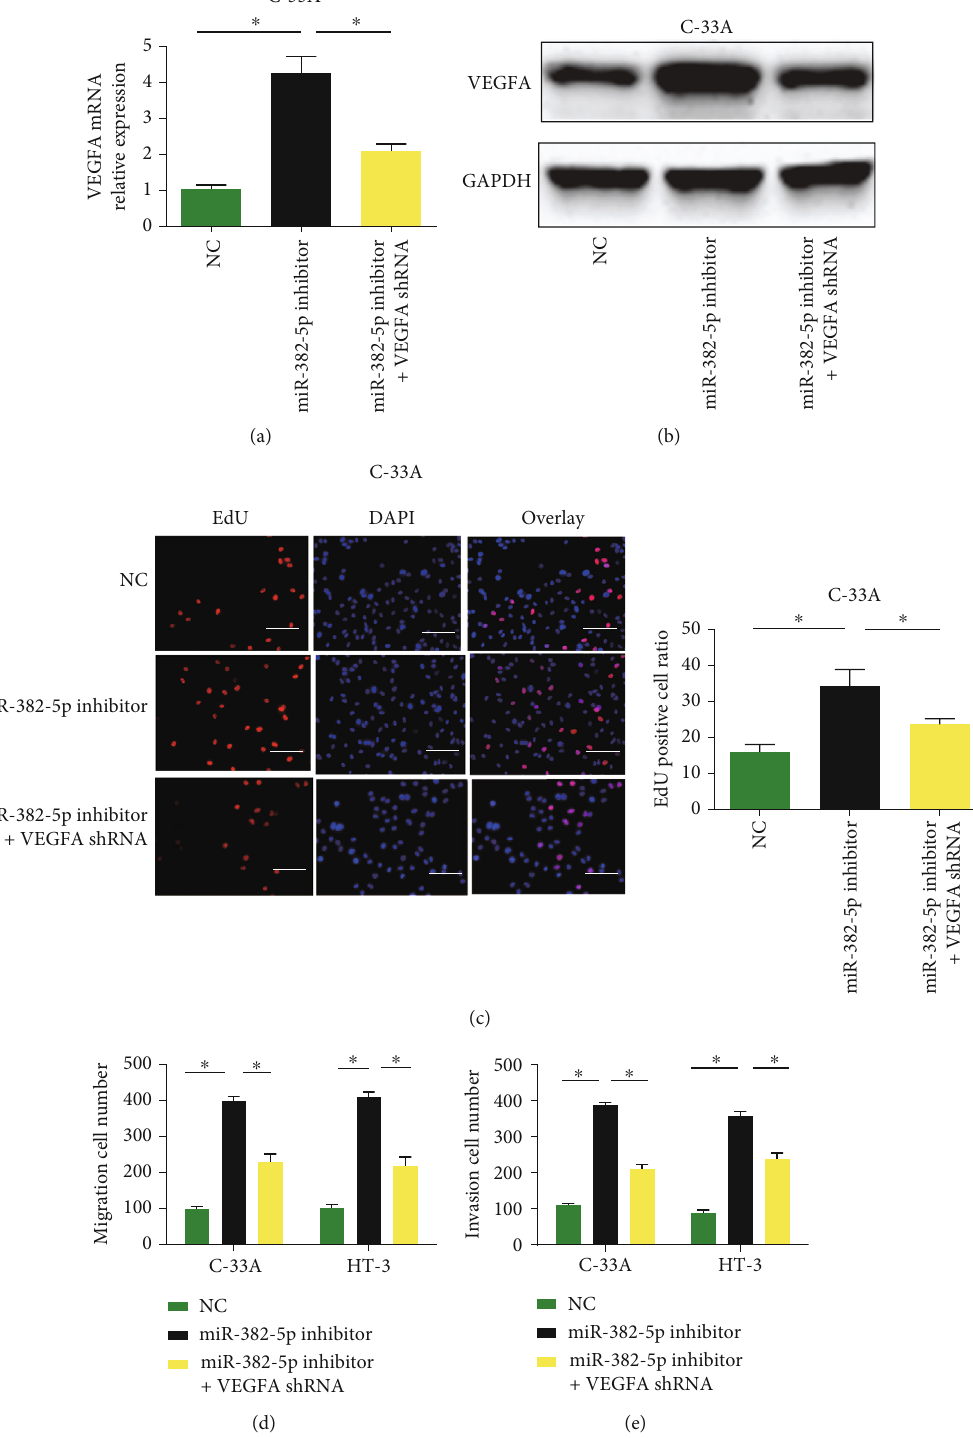
Figure 5: Loss of VEGFA repressed cervical cancer cell growth. (a, b) VEGFA expression in C-33A and HT-3 cells transfected with miR-382- 5p inhibitors and VEGFA shRNA. (c) EdU assay was used to evaluate cell proliferation ( scalebar = 50 μ m). (d, e) Cell migration and invasion. ∗ P < 0 : 05